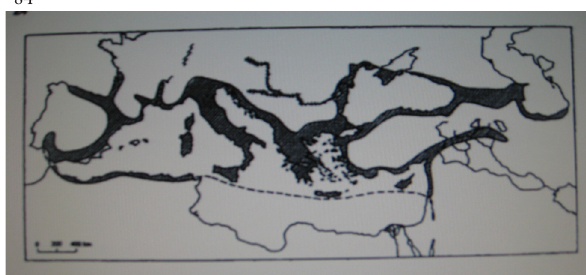
Fig. 1. Distribution of sylvestris in mediterranean basin(after Zohary,